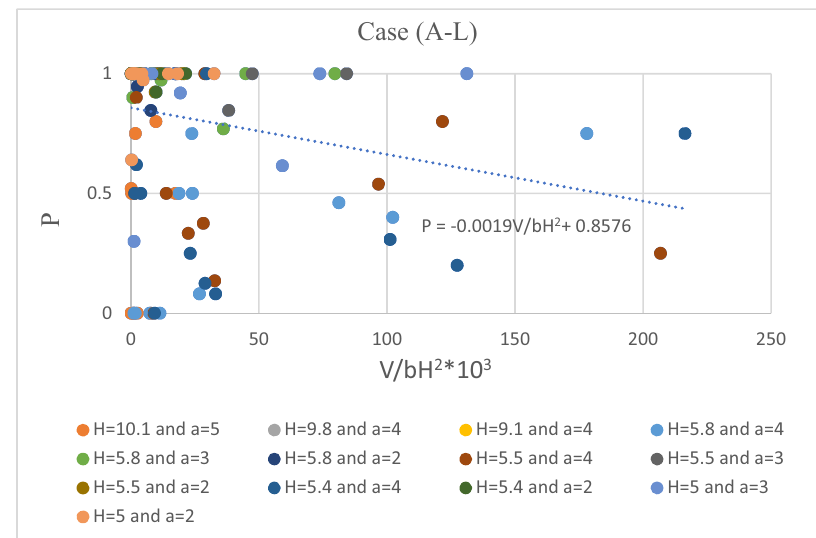
Figure 16: The relation of ( V / bH 2 ) and ( P ) for trunks and